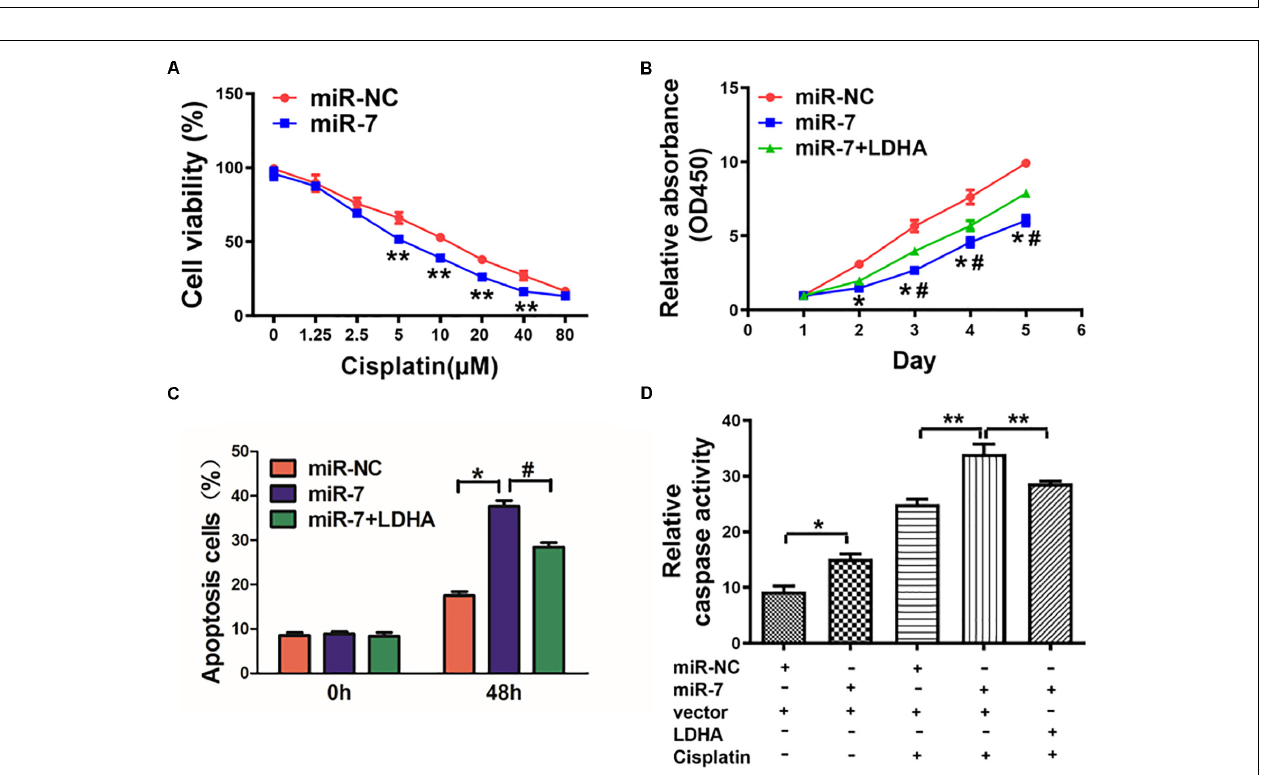
FIGURE 5 | miR-7 overexpression increased GC cell cisplatin sensitivity via LDH-A inhibition. (A) BGC823 cells that had undergone stable transduction to express miR-7 or miR-NC were treated with the indicated amounts of cisplatin prior to CCK-8 assessment (48 h after cisplatin treatment). (B) BGC823 cells that had undergone stable transduction to express miR-7, miR-NC, or both miR-7 and LDH-A were treated with the indicated amounts of cisplatin (5 µ M) prior to CCK-8 assessment. (C,D) Apoptosis was measured via flow cytometry in cells treated with or without cisplatin (5 µ M). Three independent experiments were conducted in triplicate. Data are means ± SD. * P < 0.05 vs control; # P < 0.05 vs miR-7 and LDH-A overexpression. ** P < 0.01.